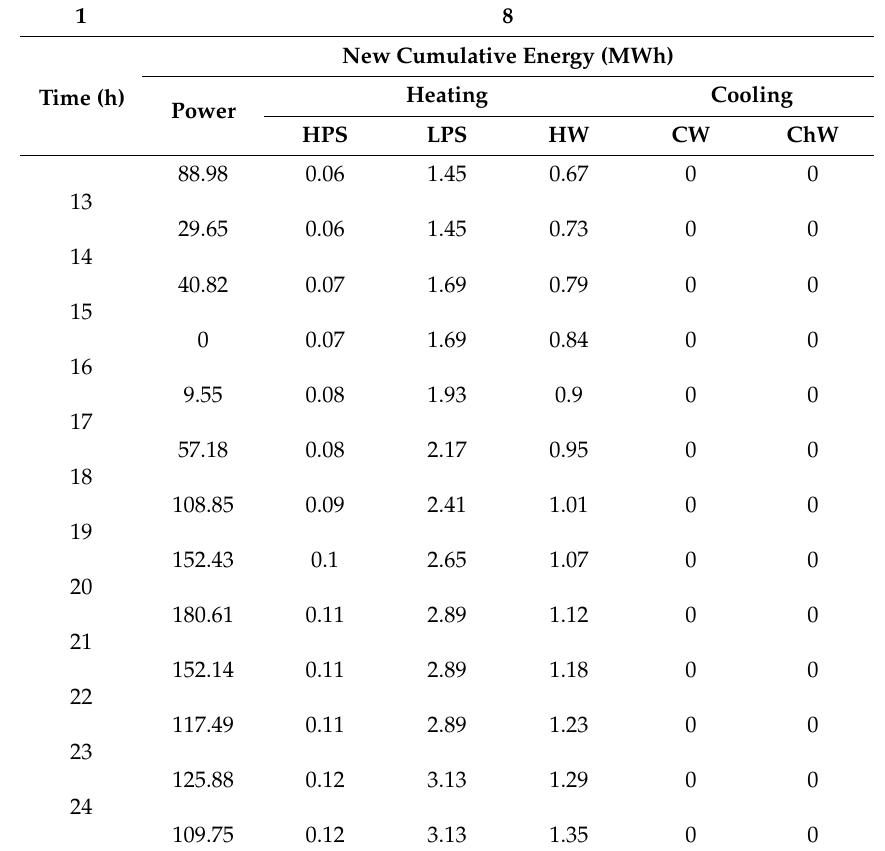
Table A16. TriGenSCA after iteration from 13 to 24 h.